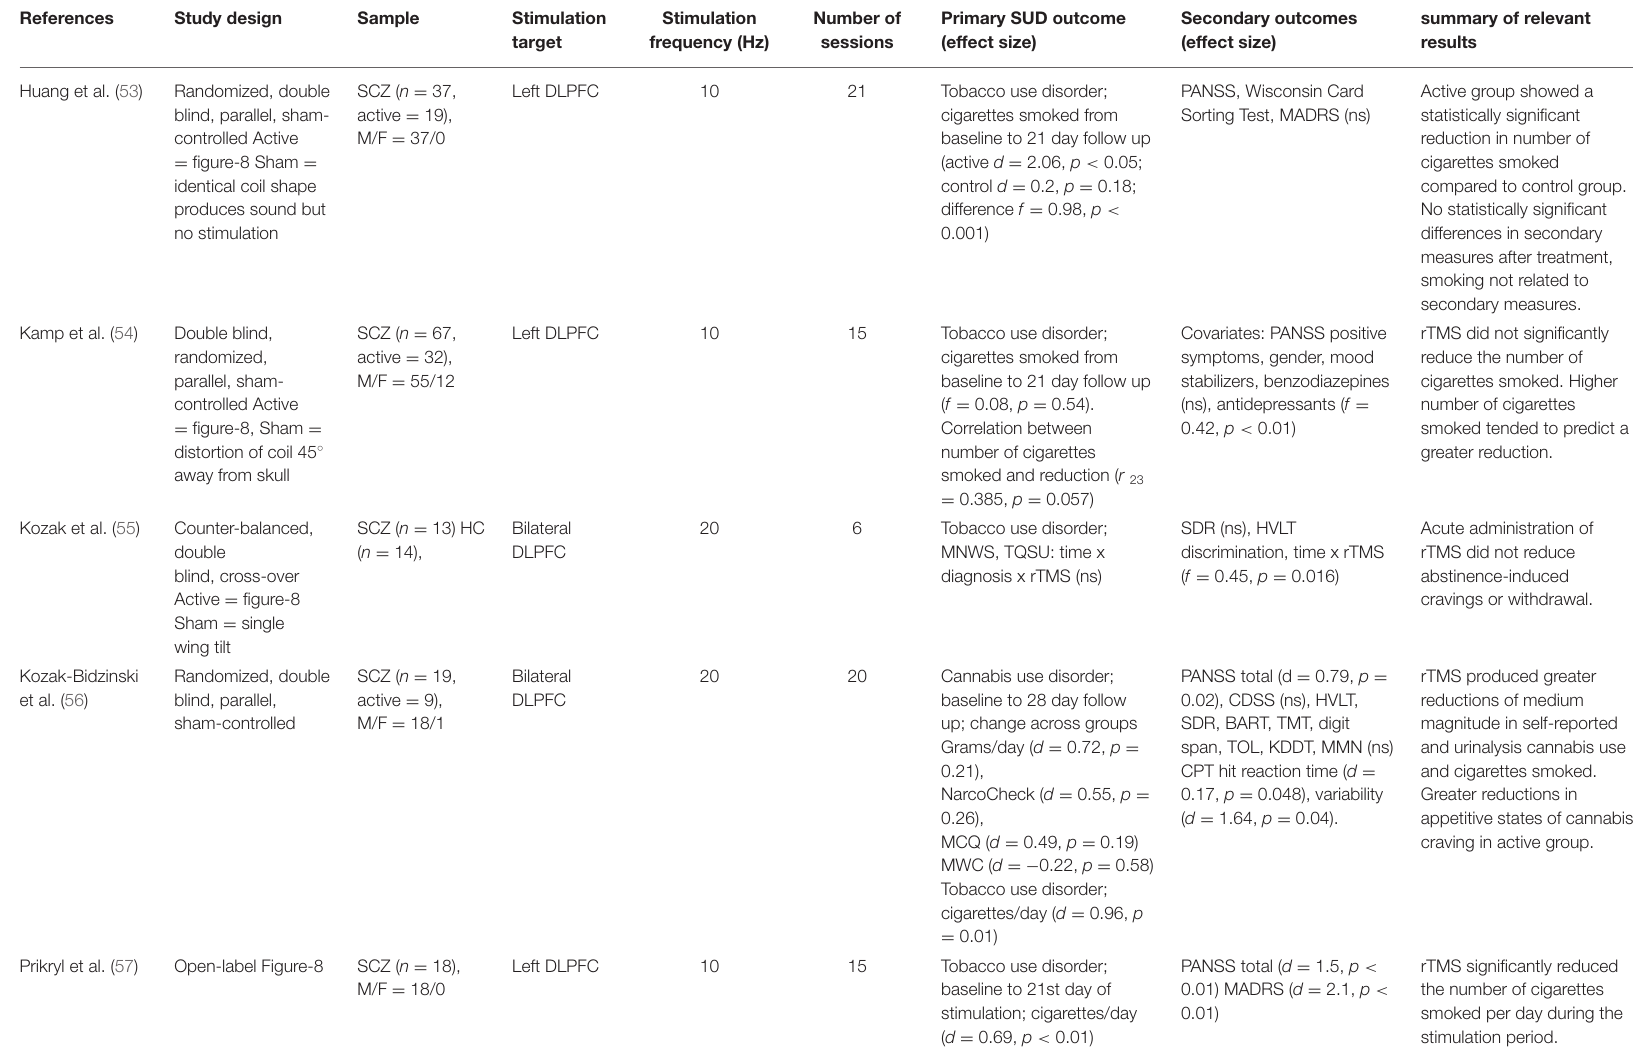
TABLE 2 | Main findings from repetitive transcranial magnetic stimulation